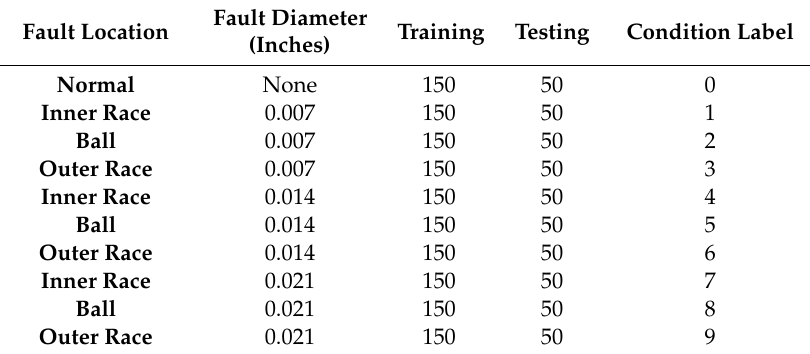
Table 2. Composition of CWRU experimental samples.